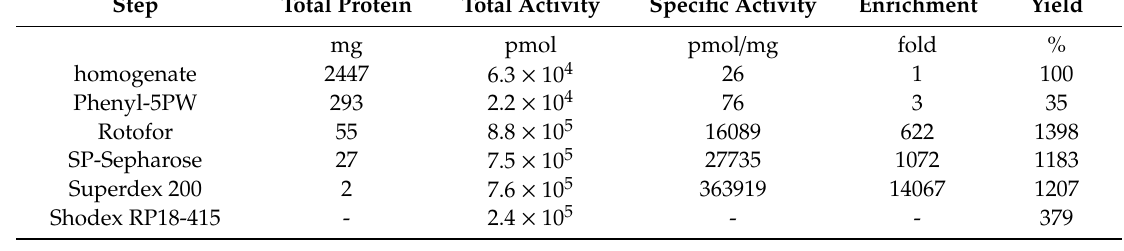
Table 1. Typical purification steps of SM deacylase from rat skin. SM deacylase activity was determined by measuring the production of SPC by LC-MS / MS as described in the Materials and Methods section.